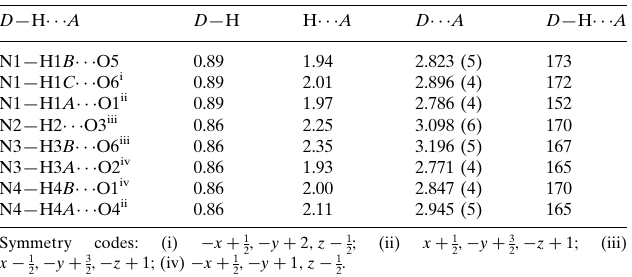
Hydrogen-bond geometry (A˚ , (cid:4)